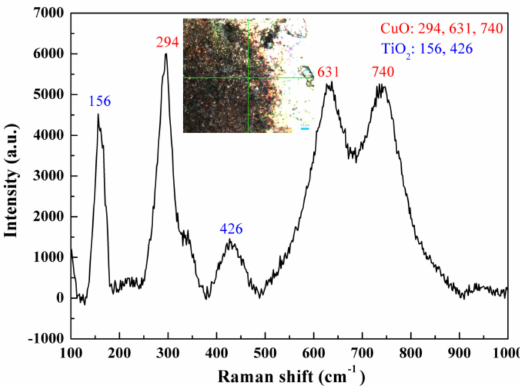
Figure 6. Raman spectrum of Cu-Ti 3 AlC 2 surface after being eroded 100 times by arc discharging.